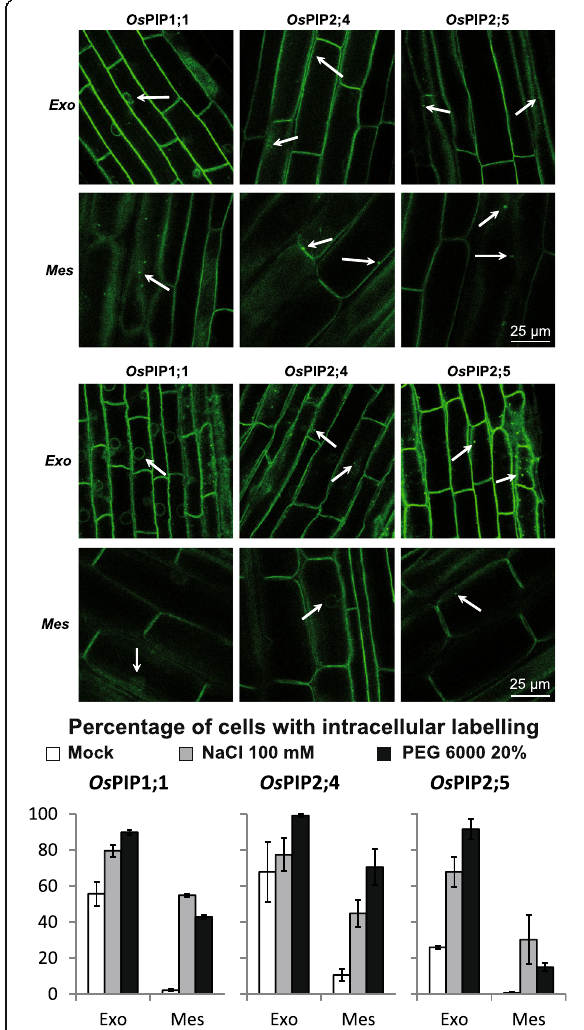
Fig. 4 Effects of salinity and osmotic stress on subcellular localization of rice PM aquaporins in root. Control, salt or PEG treatments were applied on whole root systems and crown root cells were observed by laser scanning confocal microscopy. Intracellular labelling observed upon salt (upper) and osmotic stress (middle) are indicated with arrows. Each column refers to an isoform and each line refers to a cell layer, either exodermis (Exo) or mesodermis (Mes). (Lower) Quantification of intracellular labelling upon either control treatment with water (opened bars), 100 mM NaCl (grey bars) or 20% ( w / v ) PEG6000 (closed bars) for 30 min, respectively. The mean values and ± SEs are